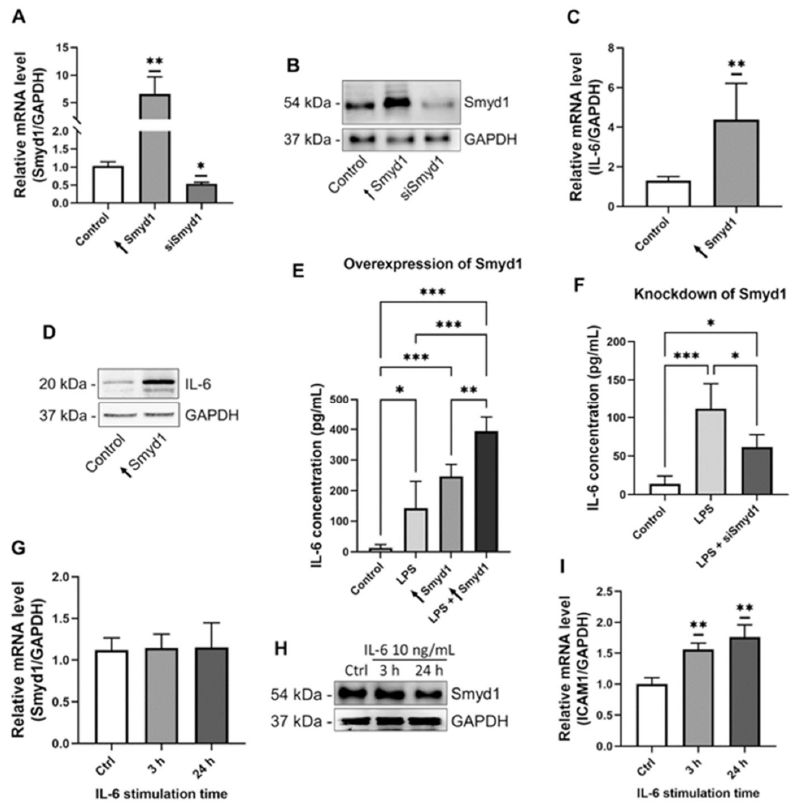
Figure 2. Smyd1 increases IL ‐ 6 expression and secretion in endothelial cells . ( A , B ) RT ‐ qPCR to quantify Smyd1 mRNA levels ( A ) and immunoblotting for the determination of Smyd1 protein levels ( B ) in pCMV2 ‐ Smyd1 ‐ flag vector ( ↑ Smyd1) or Smyd1 ‐ specific siRNA transfected EA.hy926 cells. Expression values relative to control (transfection with vector lacking gene insert). n = 3, * p < 0.05, ** p < 0.01 using one ‐ way ANOVA. Representative immunoblot of n = 3. ( C , D ) RT ‐ qPCR for the quantification of IL ‐ 6 mRNA levels ( C ) and immunoblotting for the determination of IL ‐ 6 protein levels ( D ) in total lysates of EA.hy926 cells, which were transfected with either a pCMV2 ‐ Smyd1 ‐ flag vector ( ↑ Smyd1) or a vector without specific gene insert (Control). Expression values relative to control. n = 3, ** p < 0.01 using Student t ‐ test. Representative immunoblot of n = 3. ( E ) ELISA for the quantification of IL ‐ 6 protein concentrations in supernatants of EA.hy926 cells transfected with a pCMV2 ‐ Smyd1 ‐ flag vector ( ↑ Smyd1) or a vector lacking a specific gene insert (Control) without or with LPS (1 μ g/mL) stimulation for 24 h. n = 7, * p < 0.05, ** p < 0.01, *** p < 0.001 using two ‐ way ANOVA. ( F ) ELISA for the quantification of IL ‐ 6 protein concentrations in supernatants of EA.hy926 cells simultaneously transfected with Smyd1 ‐ specific siRNA and stimulated with LPS (1 μ g/mL) for 24 h or scrambled siRNA (Control). n = 5, * p < 0.05, *** p < 0.001 using two ‐ way ANOVA. ( G , H ) RT ‐ qPCR to quantify mRNA levels ( G ) and immunoblotting for the determination of protein levels ( H ) of Smyd1 in EA.hy926 cells that were stimulated with 10 ng/mL IL ‐ 6 for 3 h or 24 h. Expression values relative to control (Ctrl; no IL ‐ 6 stimulation). n = 3, * p > 0.05 using one ‐ way ANOVA and representative immunoblot of n = 3. ( I ) RT ‐ qPCR to quantify ICAM1 mRNA levels in EA.hy926 cells that were stimulated with 10 ng/mL IL ‐ 6 for 3 h or 24 h. Expression values relative to control (Ctrl; no IL ‐ 6 stimulation). n = 3, ** p < 0.01 using one ‐ way ANOVA. All graphs reported as mean ± SD.